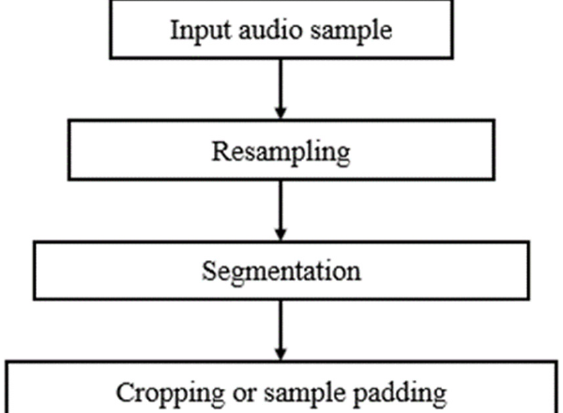
Figure 1. Block diagram of the lung sound preprocessing pipeline: at first audio samples are resampled at 4000 Hz, next each resampled signal is segmented into distinct respiratory cycles based on the experts’ annotations, and, finally, respiratory cycles of fixed duration are created using either signal cropping or sample padding.